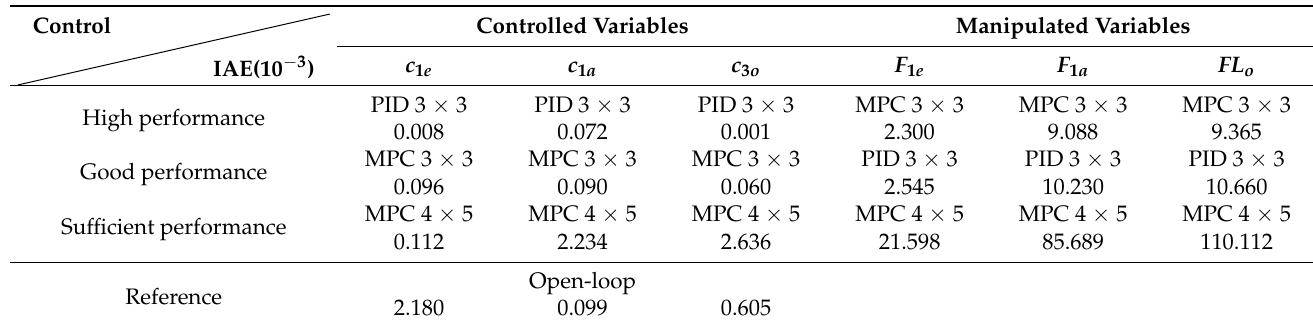
Table 2. Analysis and interpretation of results obtained by controllers, SX